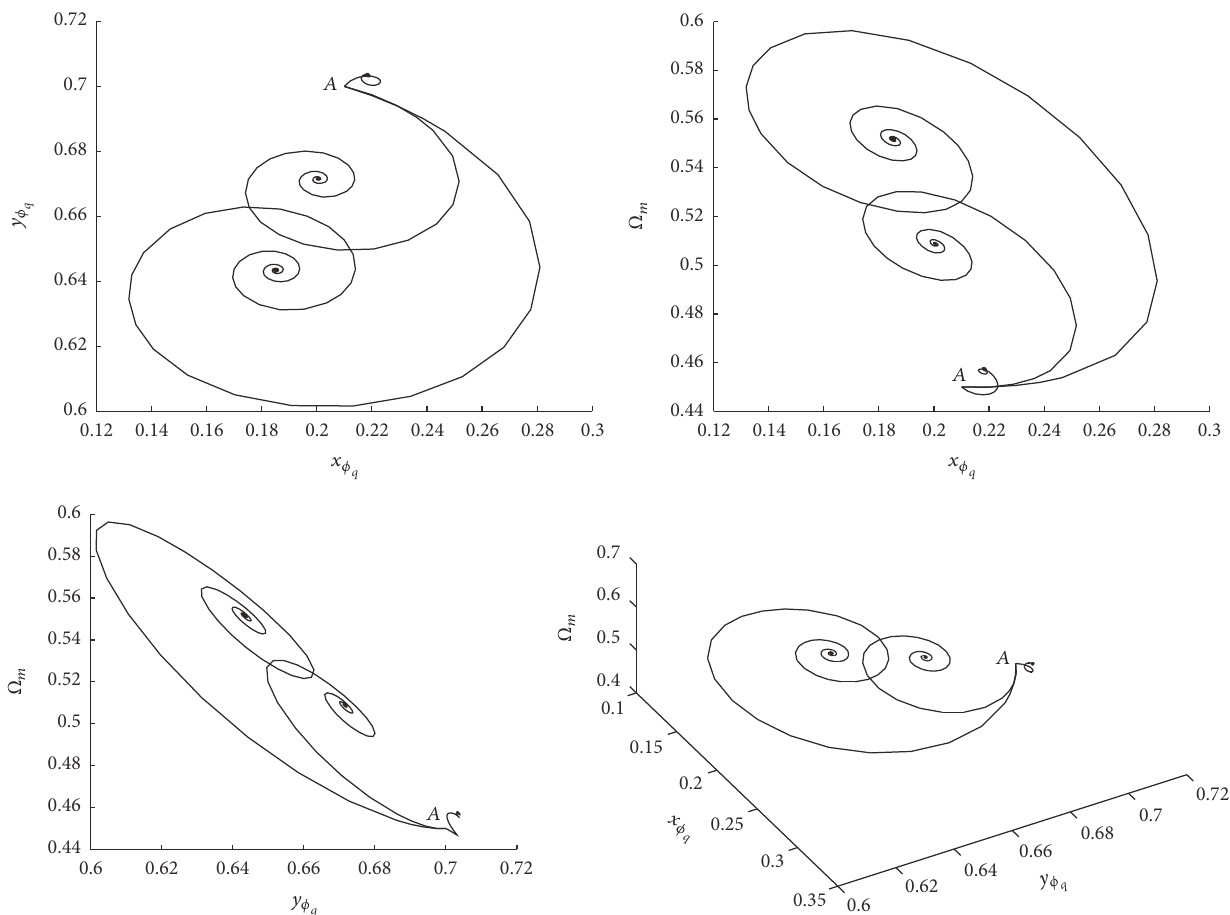
Figure 1: Two- and three-dimensional projections of the phase-space trajectories for 𝛽 = 2.51 , 𝜆 = 3.1 , 𝜆 = 3.6 , and 𝜆 = 4.1 . All plots begin from the critical point 𝐴 = (0.21, 0.70,0.45, 0) being a stable